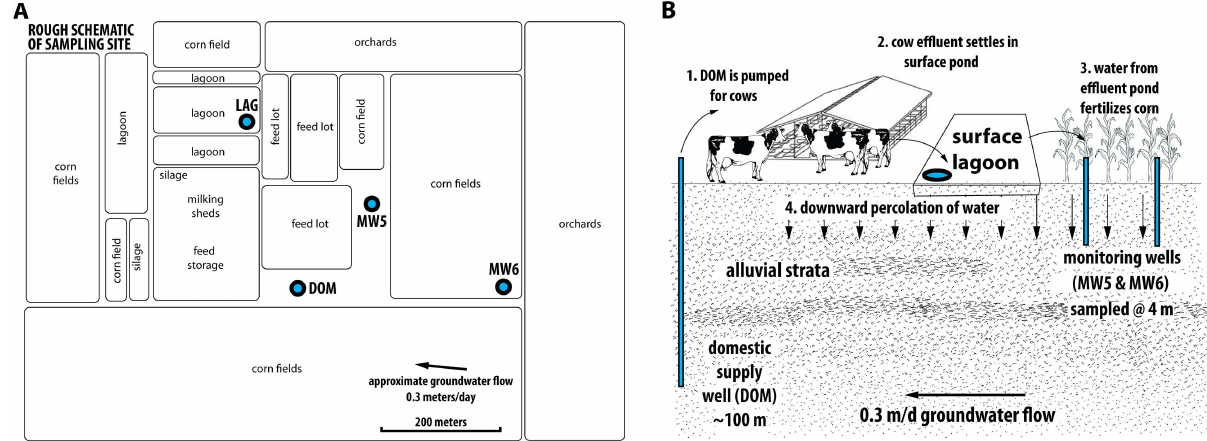
Fig 1. Dairy schematic. Cartoon of the samplingsites. (A) Roughlyto scale layout of the samplingsites along with land use practices. (B) Illustration of vertical distribution of samplingsites. Wells, depths, and approximate characteristics of the aquifer are depicted.